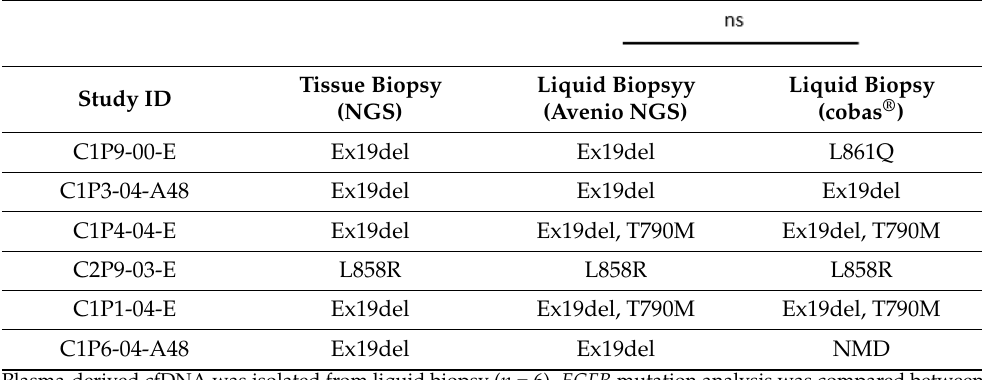
Table 4. Comparative assessment of the AVENIO ctDNA targeted NGS panel and the cobas ® EGFR mutation v2 test.